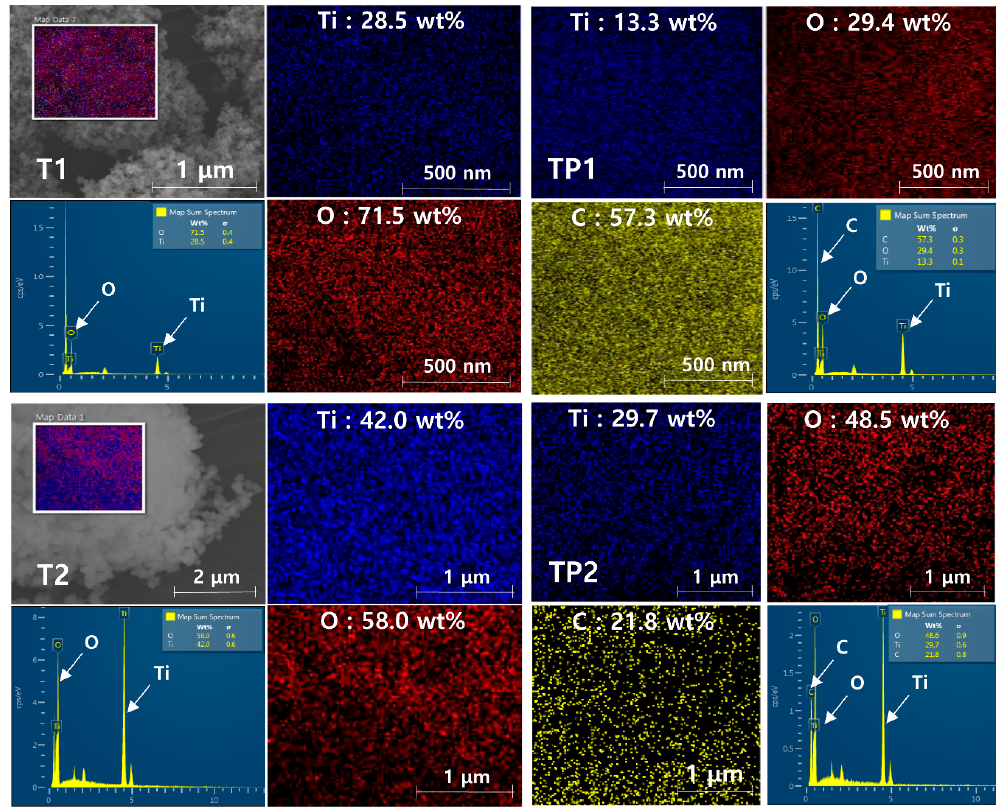
Figure 5. EDS mapping images and EDS spectra of the pure TiO 2 nanoparticles (T1 and T2) and the TiO 2 /PMMA hybrid nanoparticles (TP1 and TP2).